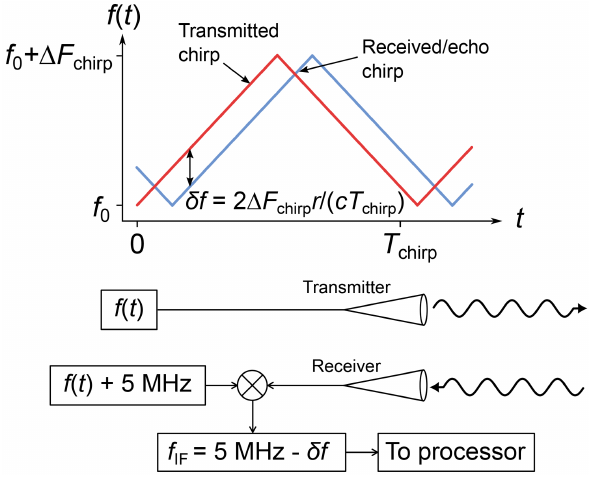
Figure 3. Basic FMCW radar schematic. See Sect. 2.2 for discus-